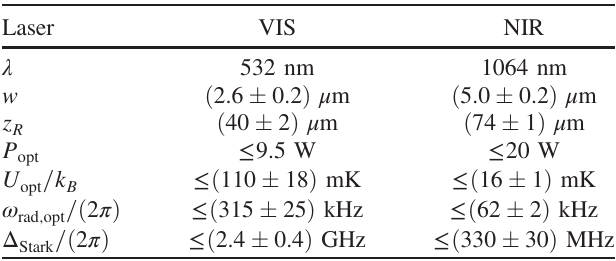
≤ ð 330 (cid:2) 30 Þ